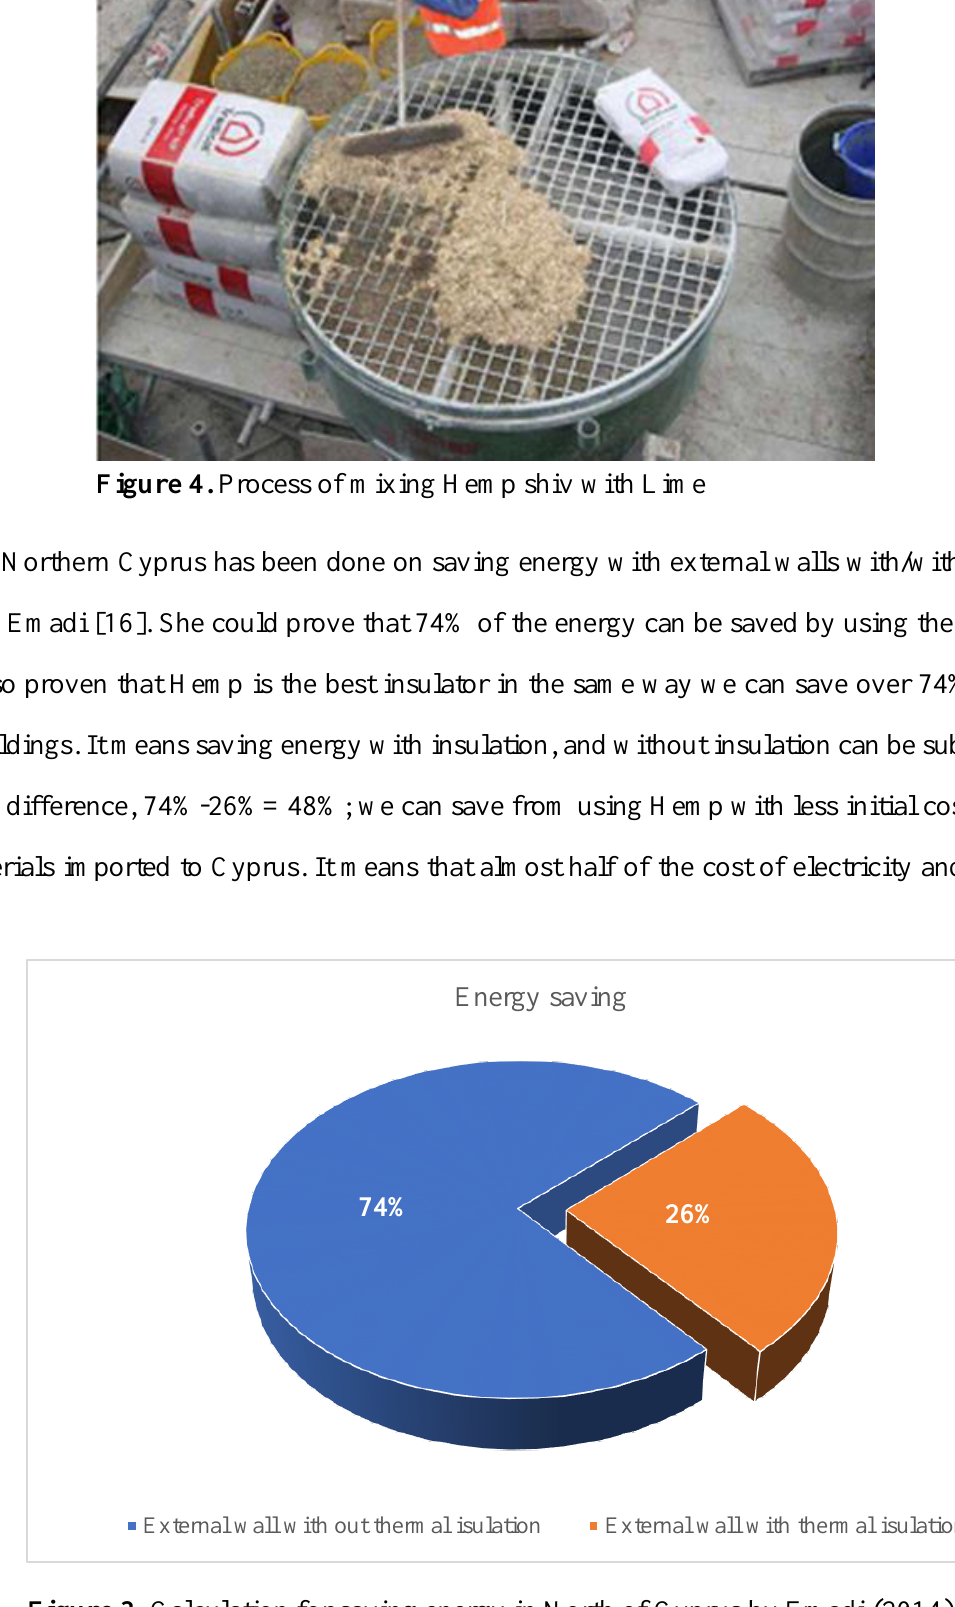
Figure 3. Calculation for saving energy in North of Cyprus by Emadi